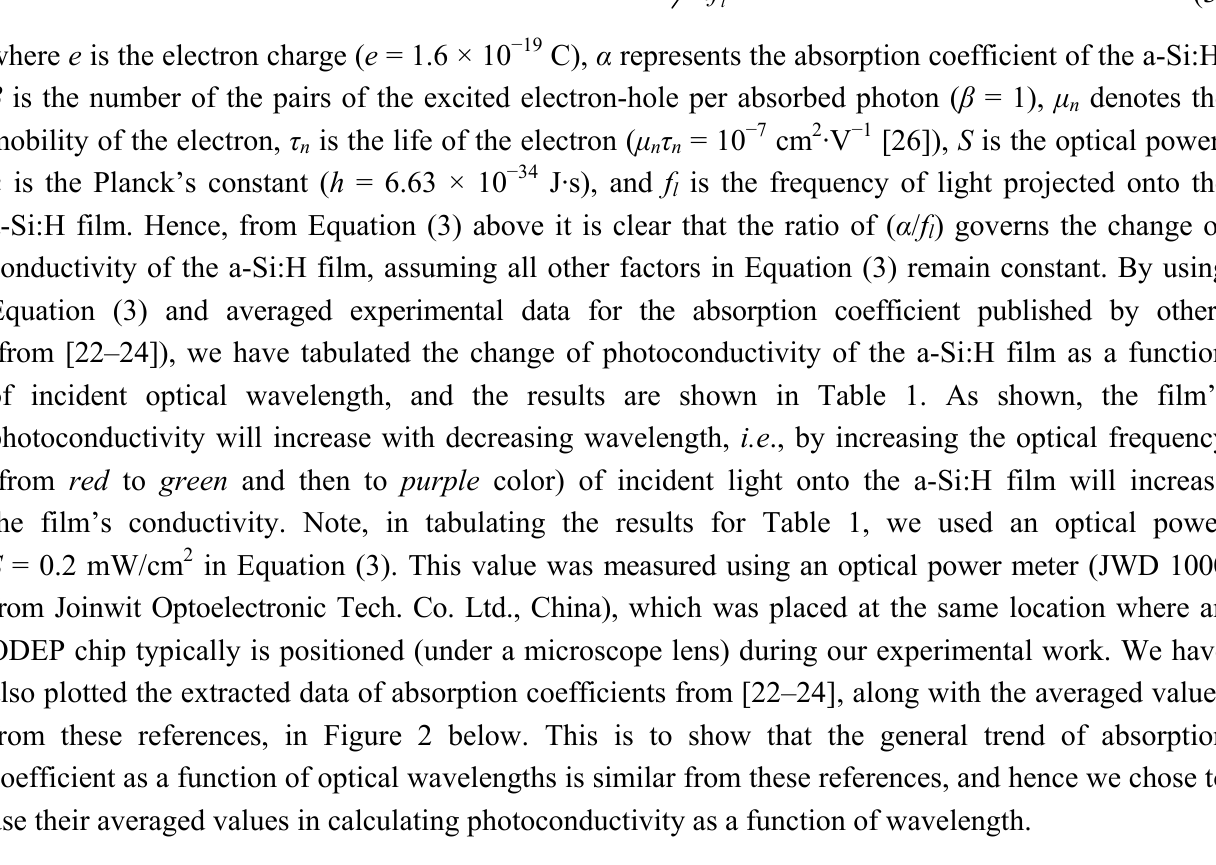
Table 1. Photoconductivity of the a-Si:H as a function of different light